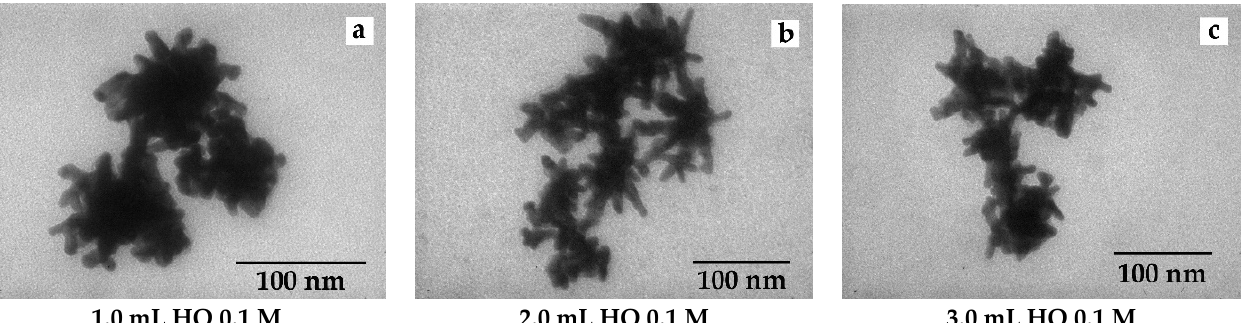
Table 5. The influence of HQ to surface plasmon resonance and intensity absorbance.